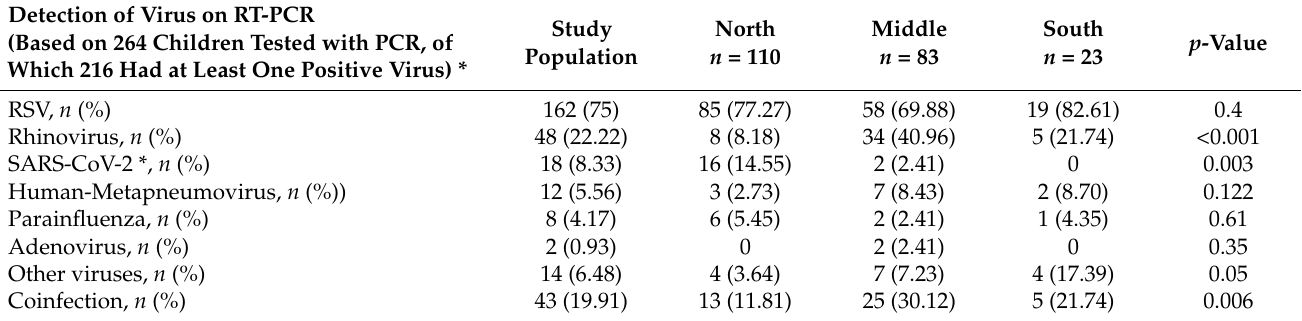
Table 2. Viral etiologies detection of at least one virus, on a total 264 children that underwent the test. RSV, respiratory syncytial